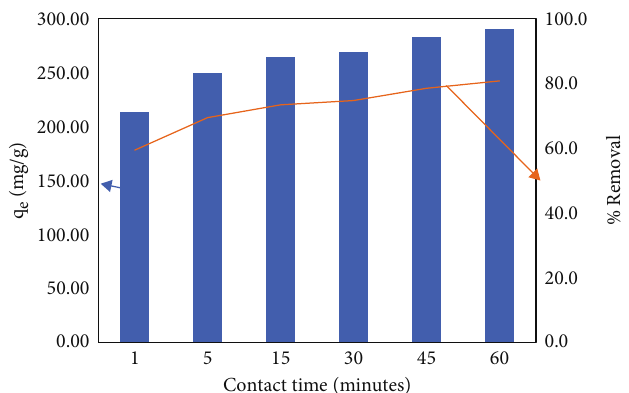
Figure 5: Contact time a ff ects MB adsorption capacity and removal percentage.